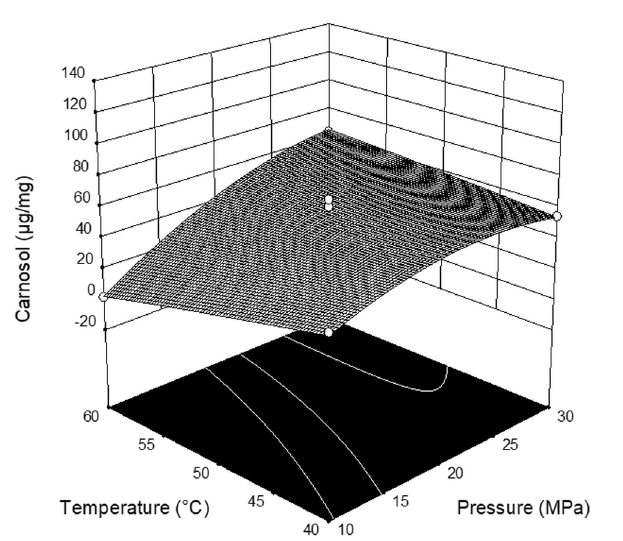
Figure 2. Three-dimensional plots for the obtained content of carnosol as a function of the extraction pressure and